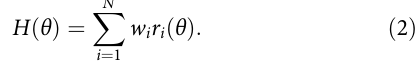
Fig. 1j. With its bell-shape, it accurately mimics the neural tuning curve schematized in Fig. 1c. Spin transfer torque theory 23